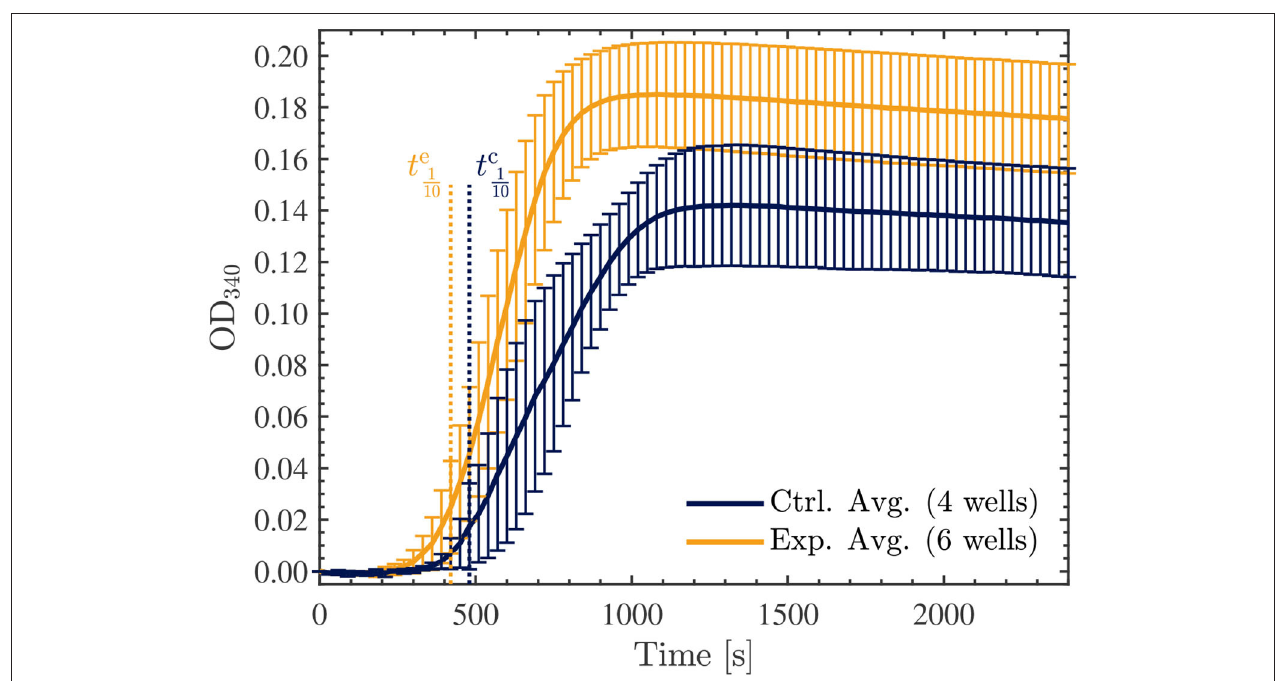
FIGURE 11 | Average optical density results of absorbance measurements performed at 340 nm, every 30 s for 40 min, on the 45.5 µ M control (blue) and exposed (yellow) tubulin samples. The tenth times of t c 1 / 10 ≃ 480 s and t e 1 / 10 ≃ 420 s calculated for the control and exposed curves, respectively, are overlayed as the dotted vertical lines shown. The data presented was collected in N = 2 independent replicate